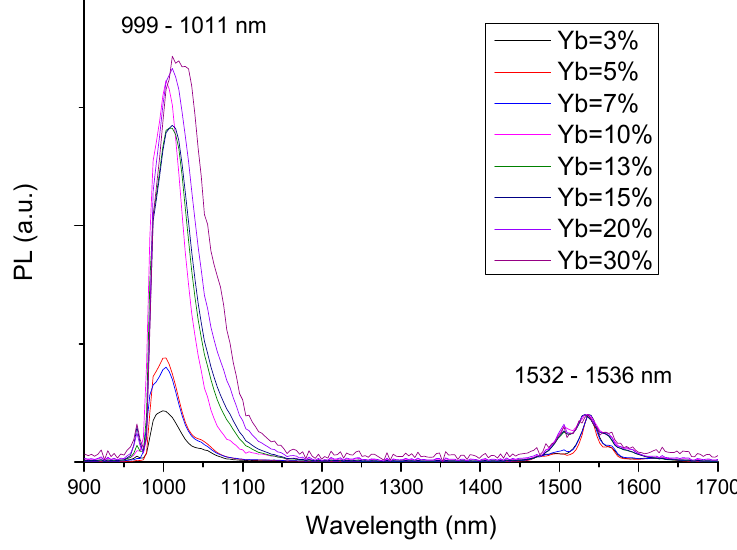
Figure 5. Normalized photoluminescence (PL) emission spectra of Yb/Er co-doped phosphosilicate bulk glass samples, excited at 970 nm.